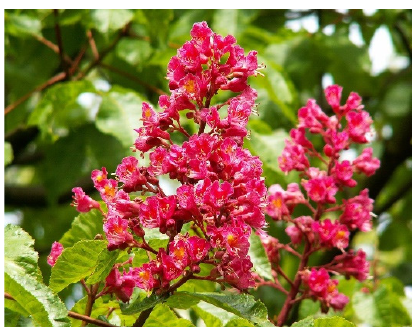
Figure 5. Flowers of Aesculus (×) carnea (red horse chestnut flowers).